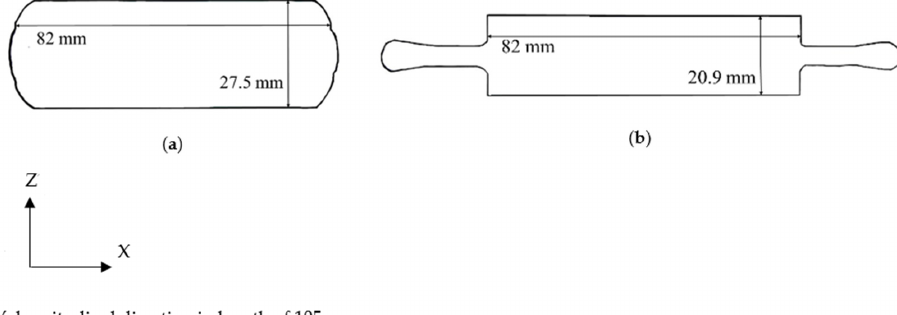
Figure 1. Drawings of ( a ) CF50, RF50, and HF50 (27.5 mm × 82 mm × 105 mm in length), and ( b ) HF62 (20.9 mm × 82 mm × 105 mm in length).